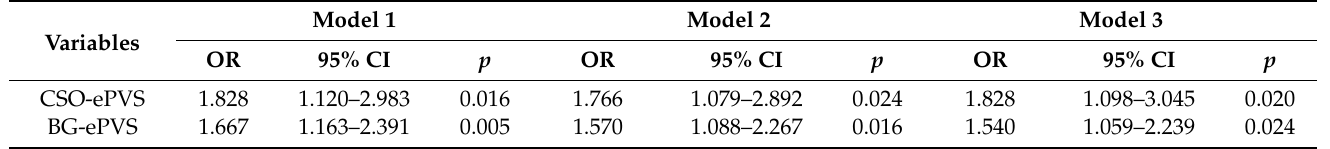
Table 5. Correlation between the severity of ePVS and the presence of DWMH.